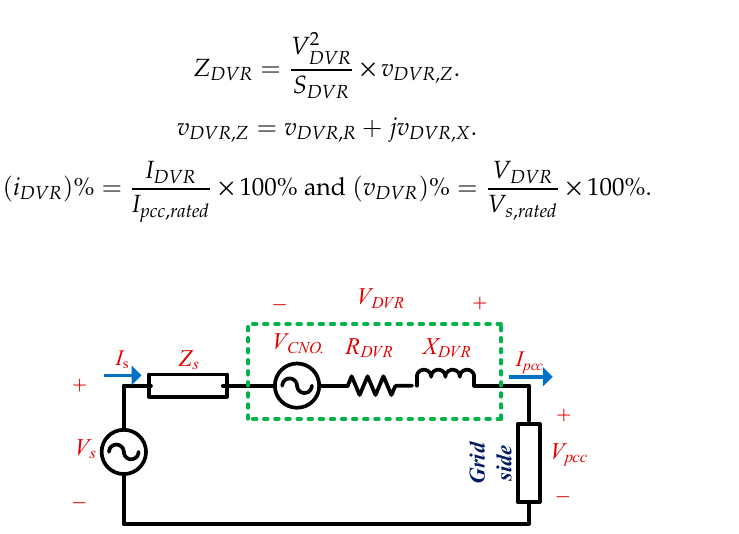
Figure 8. The simplified dynamic voltage regulator (DVR) model.